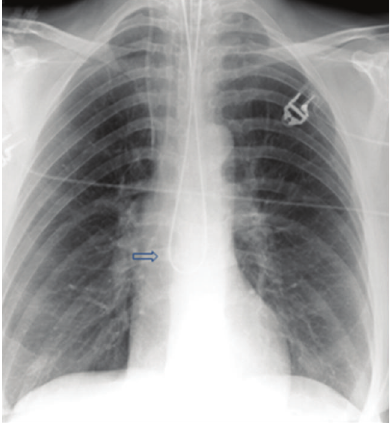
Figure 31: A CXR shows an NGT tube doubled up in a “hair pin” (arrow) fashion with reentry of its tip into the